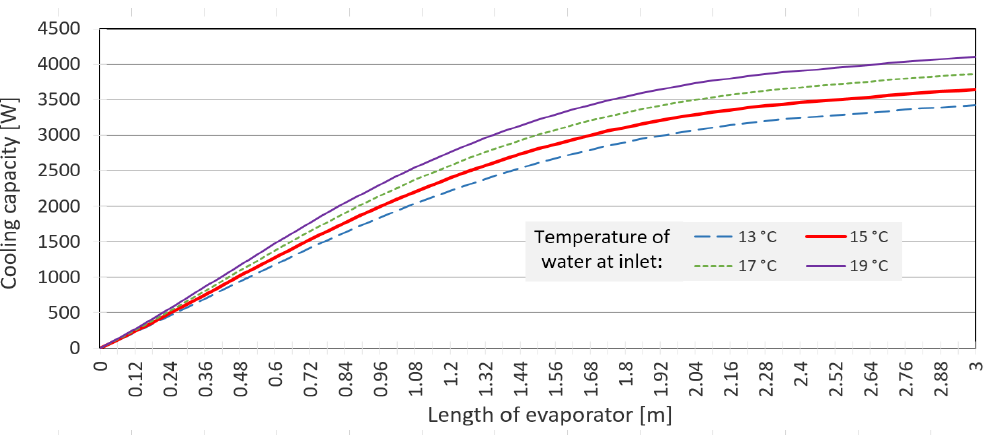
Figure 7. Variation of cooling capacity.